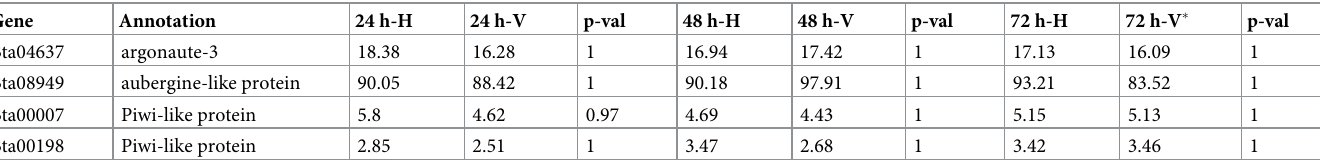
Table 1. Expression of genes encoding the core components of piRNA